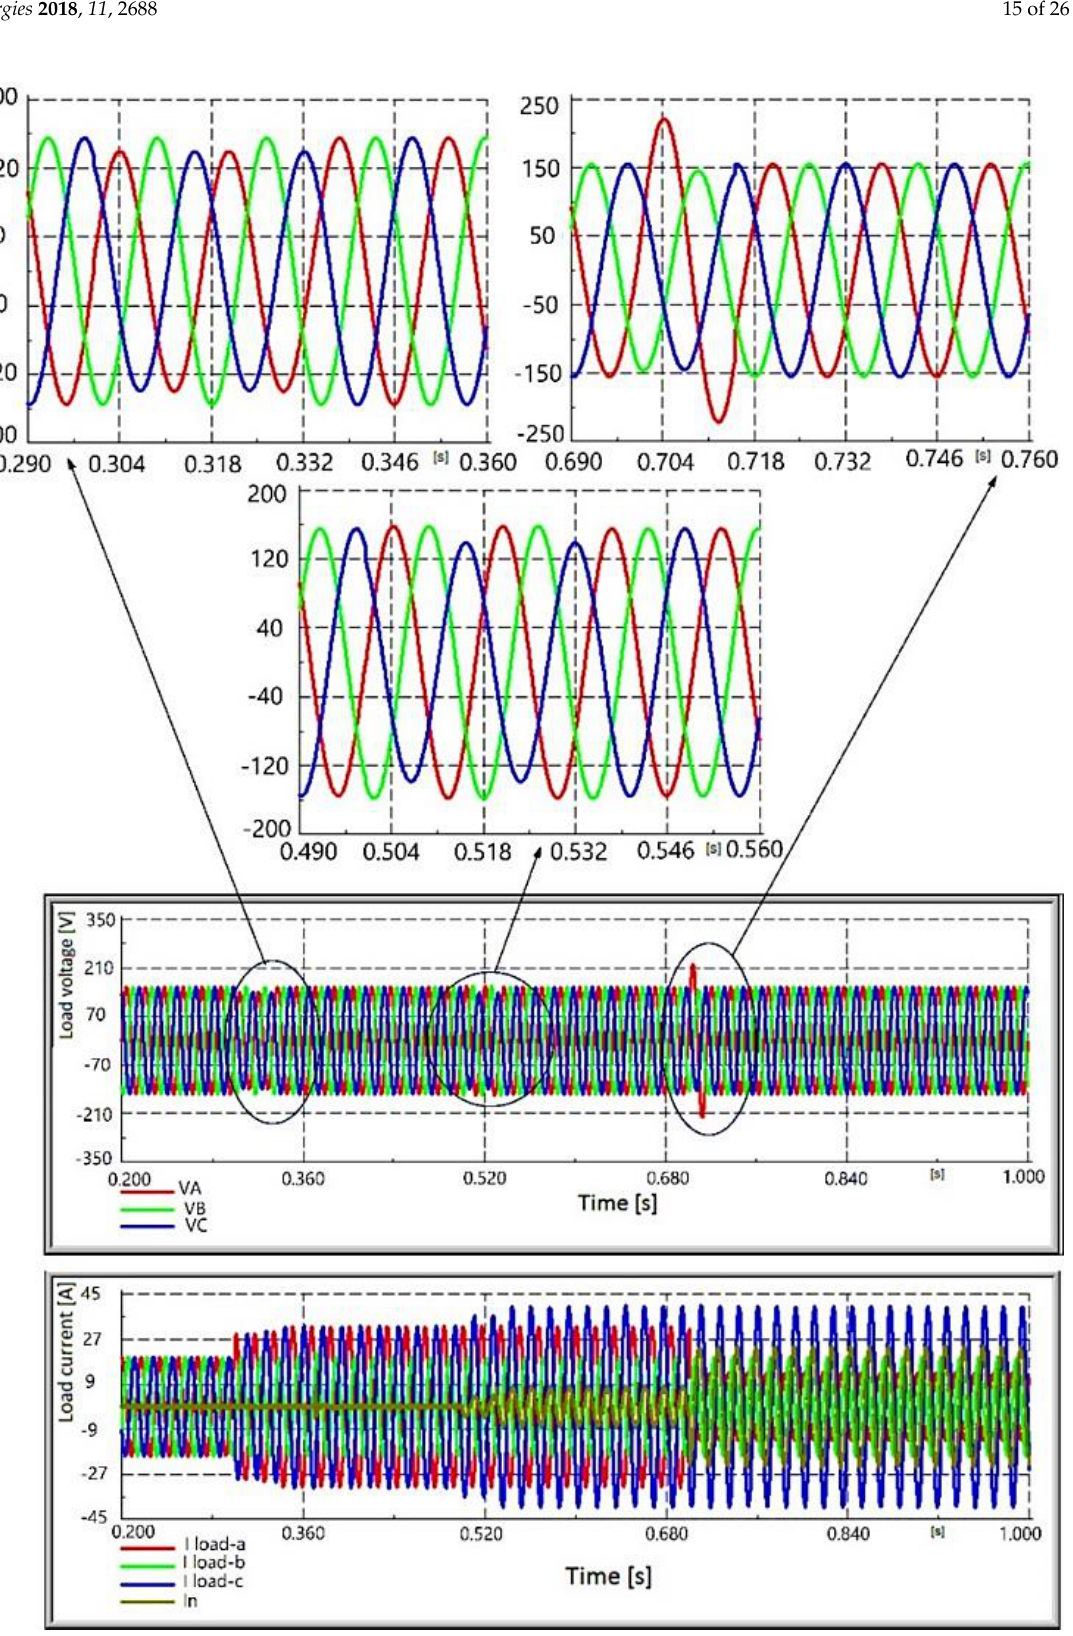
Figure 9. Output voltages and currents with the conventional control strategy under suddenly load changes.